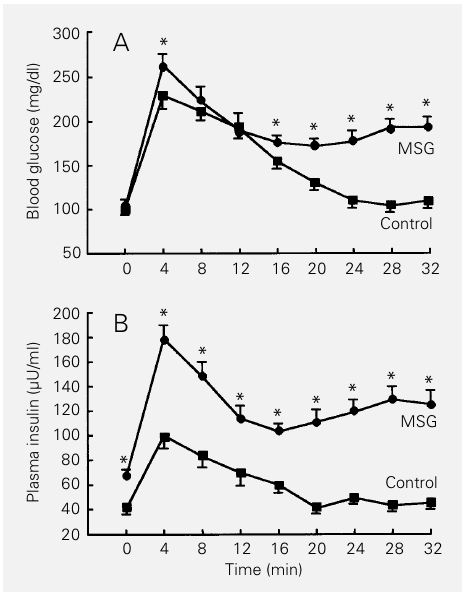
Figure 1 - Time course of blood glucose (A) and insulin concen- trations (B) before and after 0.75 g/kg glucose infusion in MSG- obese rats. Data are reported as means – SEM for 6 rats in each group. *P<0.001 compared to saline control (one-way analysis of variance (ANOVA) followed by the Mann-Whitney